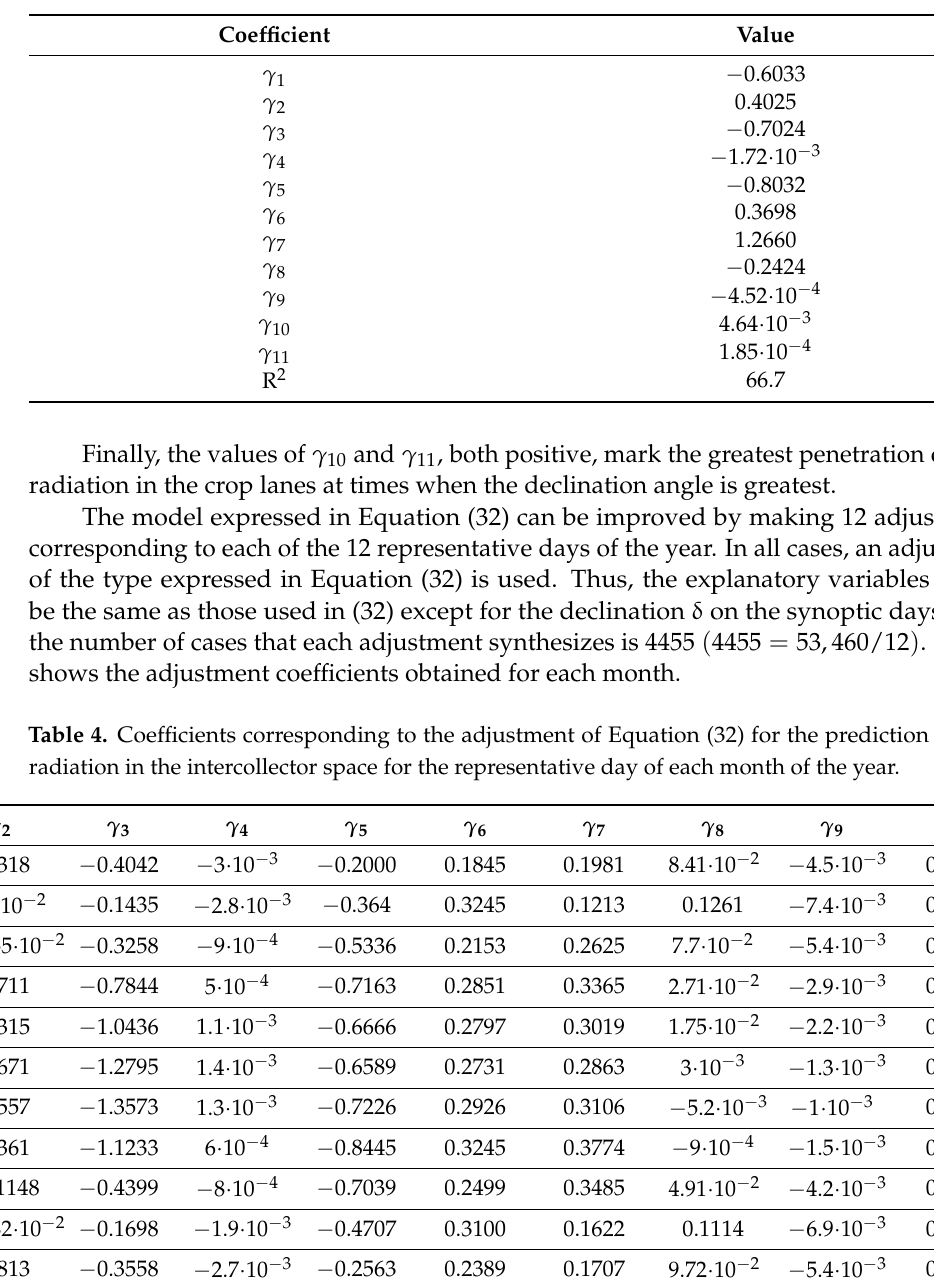
Table 3. Coefficients corresponding to the adjustment of Equation (32) for the prediction of solar radiation in the space between PV collectors.